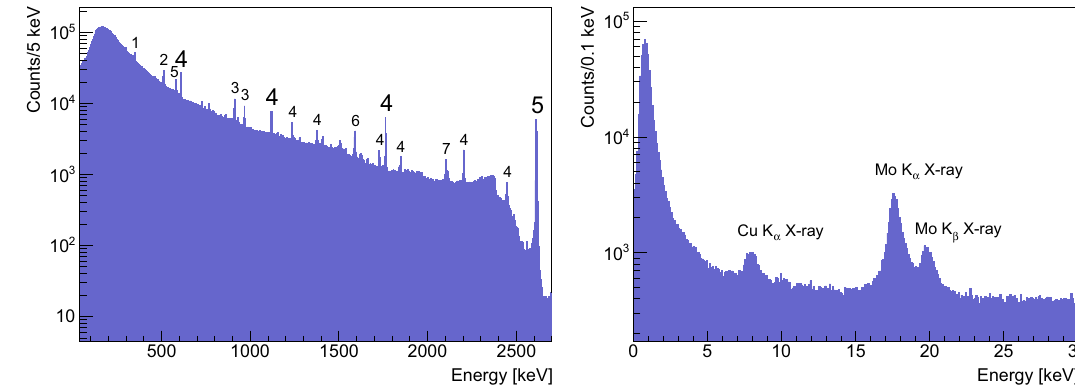
Fig. 3 CUPID-Mo calibration spectra for both LMO detectors and LDs. Left: Calibration spectra for LMO detectors exposed to the 232 Th/ 238 Usource.Aselectionofthemostprominentpeaksarelabeled: (1) 214 Pb, (2) e − e + annihilation, (3) 228 Ac, (4) 214 Bi, (5) 208 Tl, (6) the double escape peak for 2615 keV and (7) the single escape peak for